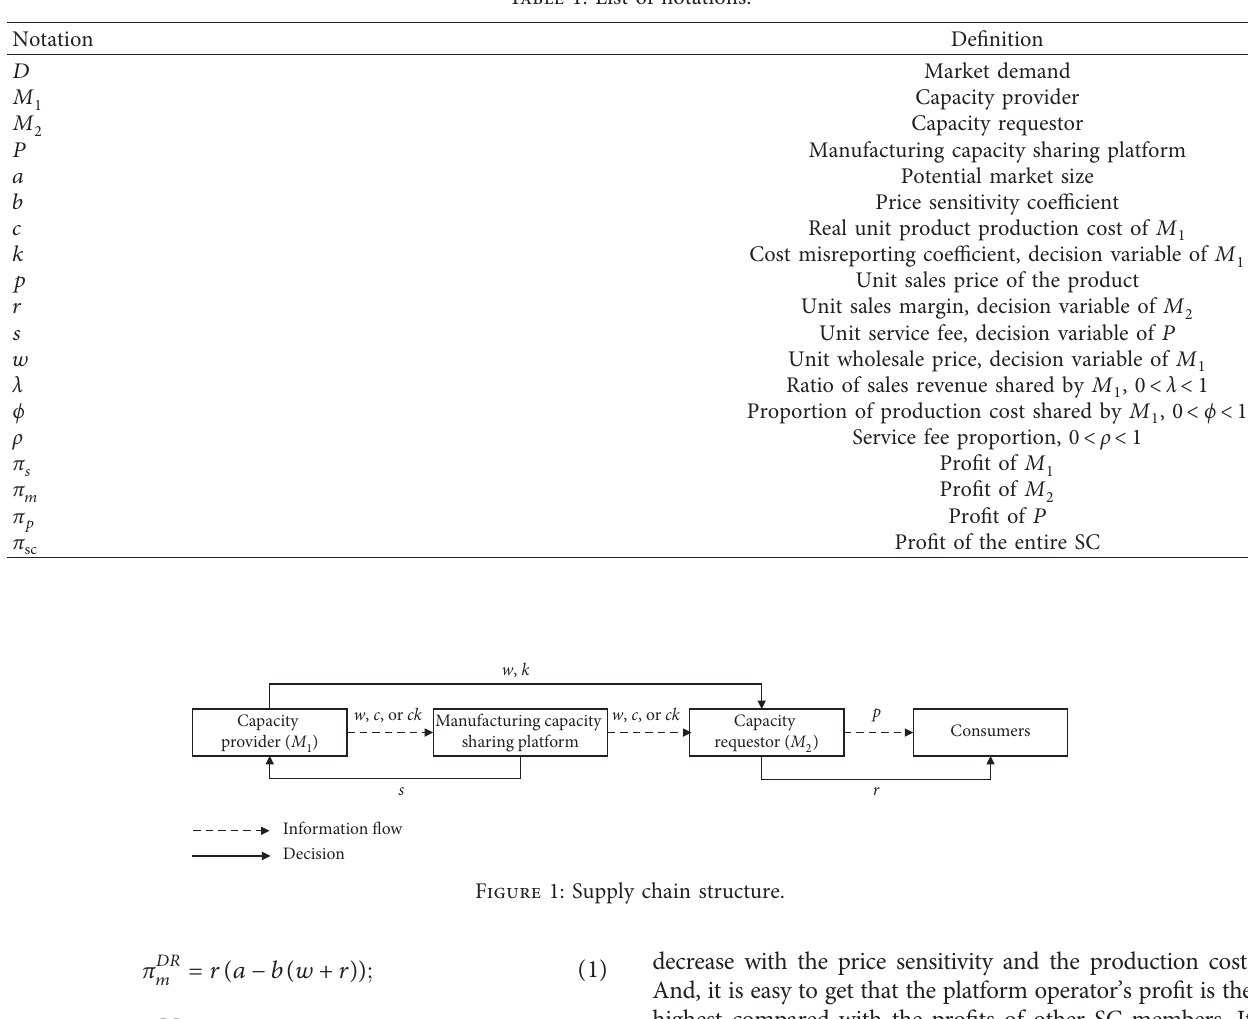
Table 1: List of